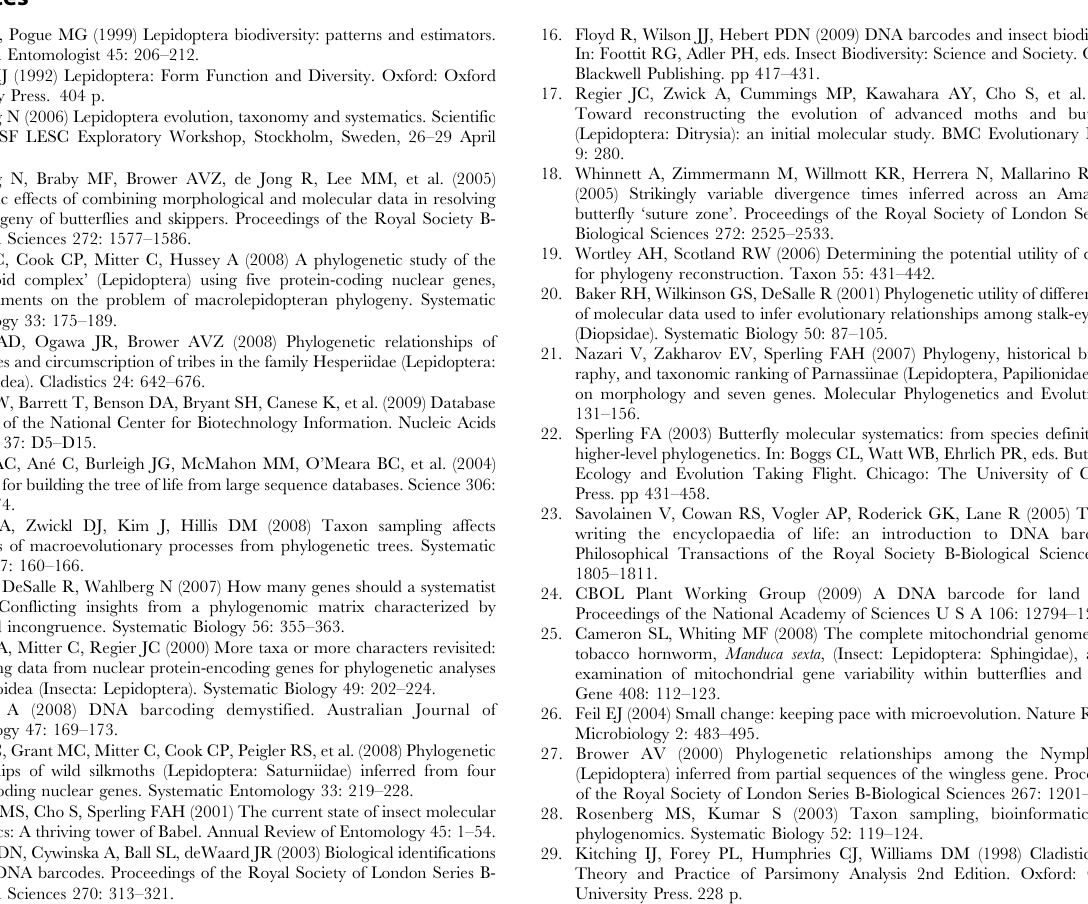
(Table 3) and averaged for four taxonomic levels: Genus, Subfamily, Family and Superfamily.